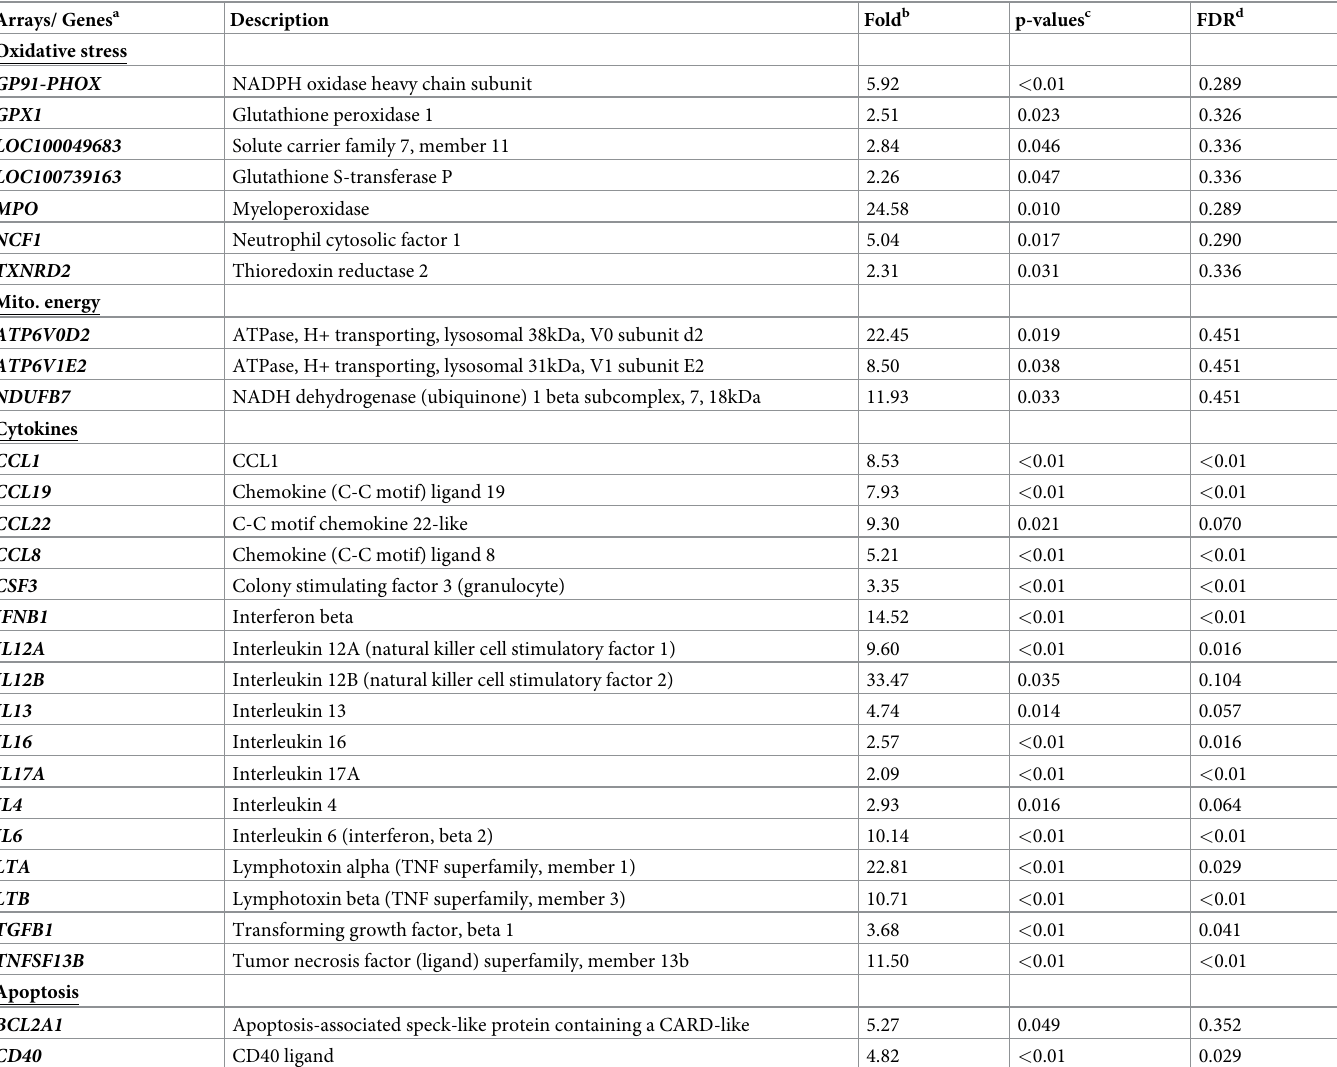
Table 3. Differently expressed genes identified by RT 2 -profilers arrays in the intestinal mucosa of 23 versus 14 days old Normal Birth Weight (NBW) piglets. Arrays/ Genes